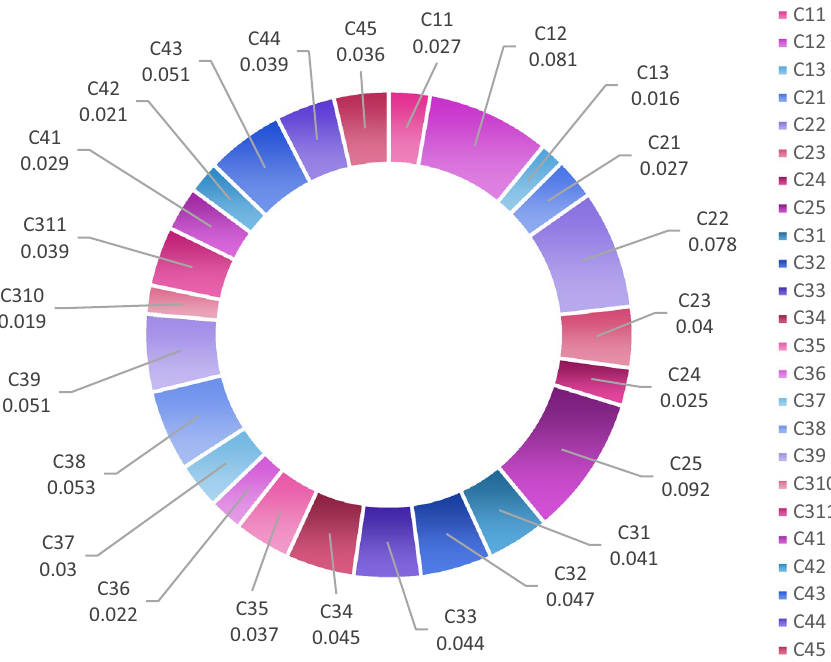
Figure 5. The aggregated criteria weights distributions. The aggregated weights of criteria employs to produce relative weight of each criterion provided ranking of the alternatives according to the loss-averse behavior of the